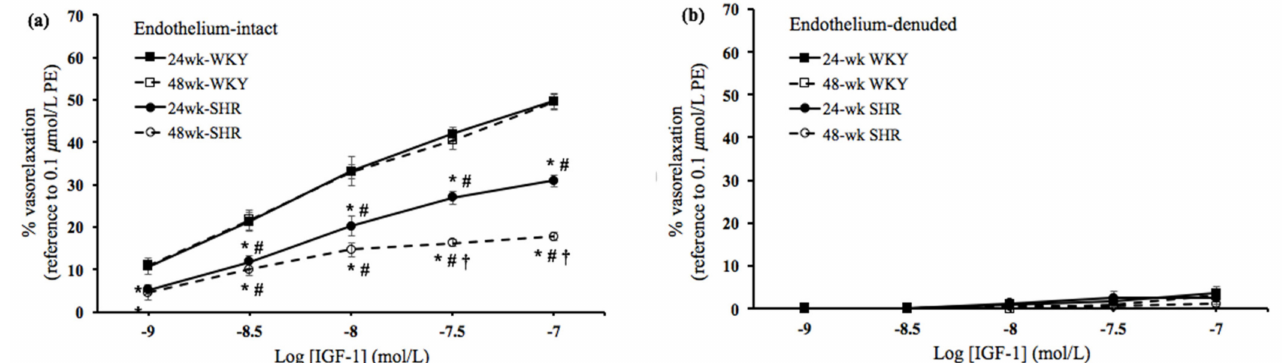
Figure 2. IGF-1–mediated vasorelaxation. IGF-1 (10 − 9 to 10 − 7 mol/L)–mediated vasorelaxation at cumulative concentration– response curves in ( a ) endothelium–intact rings and ( b ) endothelium–denuded rings in the 24wk-WKY, 48wk-WKY, 24wk- SHR, and 48wk-SHR groups. The vasorelaxing responses were expressed as the percentages of the 0.1 µ mol/L PE–induced precontractile force. Abbreviation: PE, phenylephrine. * p < 0.05, significant differences from 24wk-WKY; # p < 0.05, significant differences from 48wk-WKY; † p < 0.05, significant differences from 24wk-SHR; n = 8 in each group.